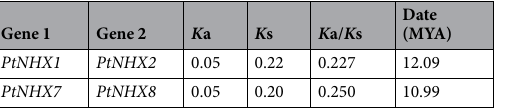
Table 2. Divergence between paralogous PtNHX gene pairs. Notes: Synonymous ( K s) and nonsynonymous substitution ( K a) rates are presented for each pair.